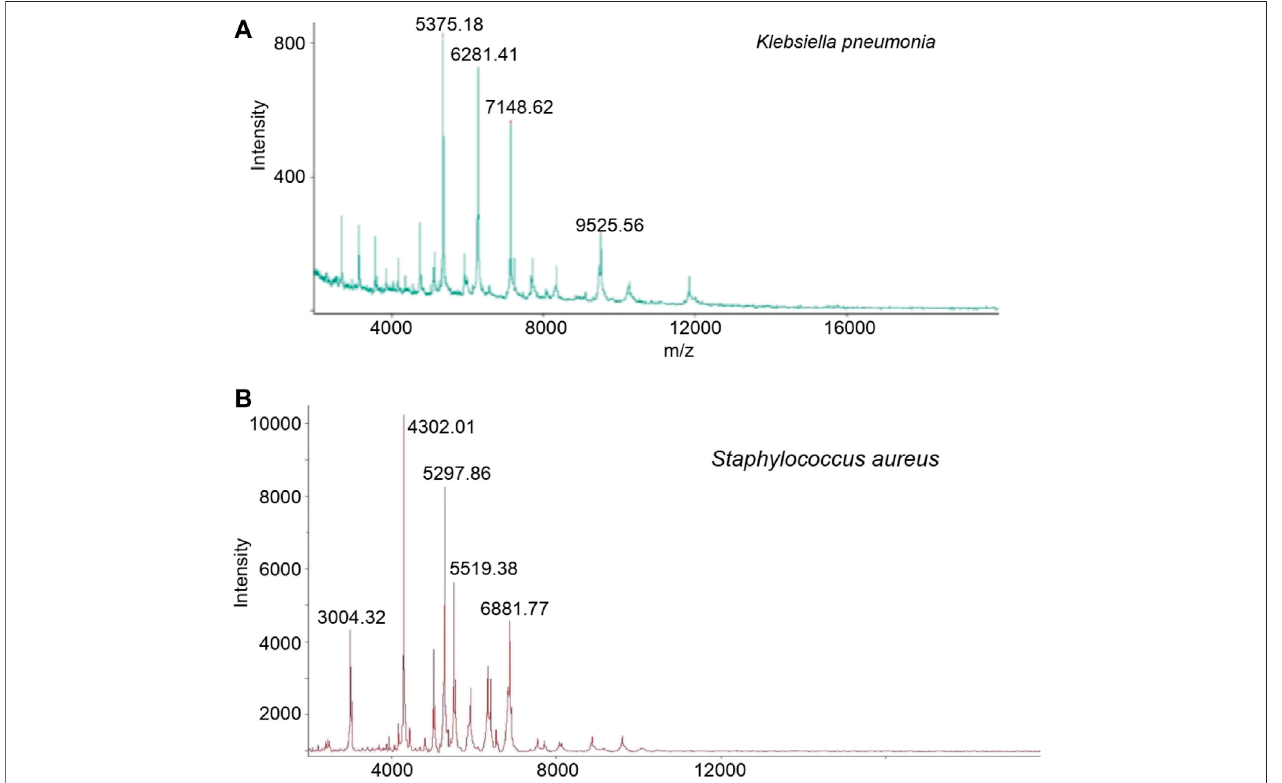
FIGURE 2 | The identi fi cation of Klebsiella pneumonia (A) and Staphylococcus aureus (B) based on MALDI TOF analysis after bacterial cultured.